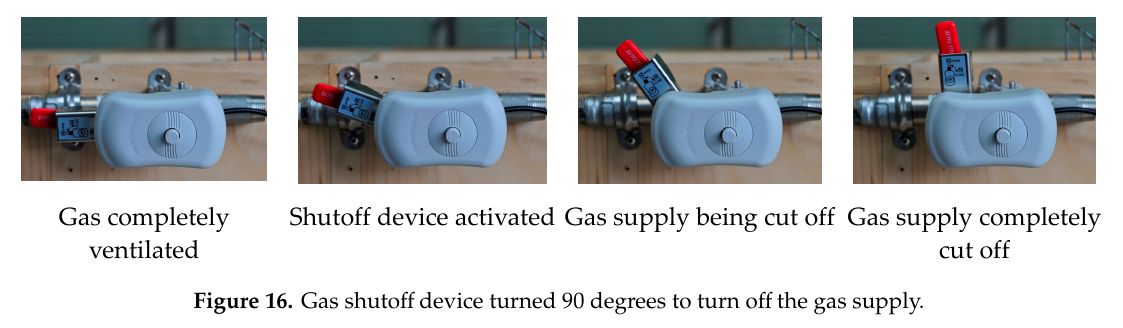
Figure 15. Activation of the alarm device.